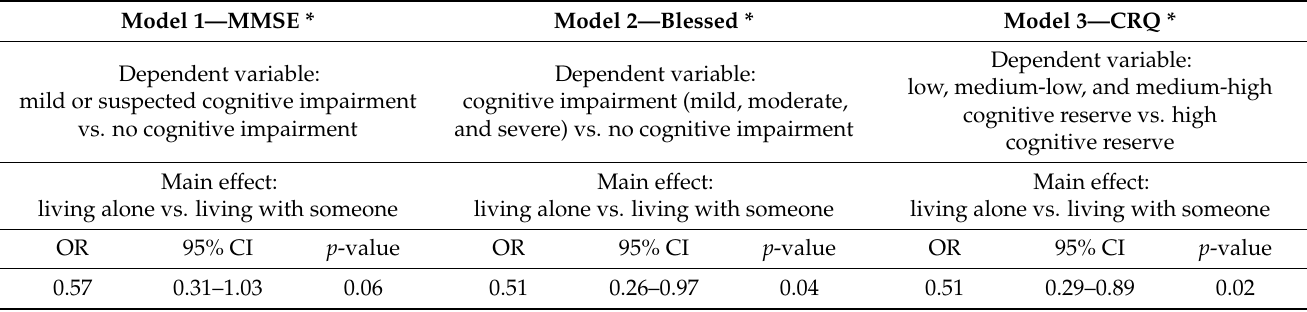
Table 4. Multivariate models to test the main effect of living alone on cognitive impairment (MMSE and Blessed) and cognitive